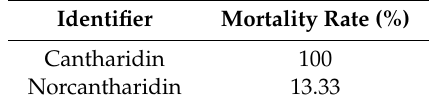
Table 3. Toxicity of cantharidin and its analogue to P. americana at 500 µ g / mL.